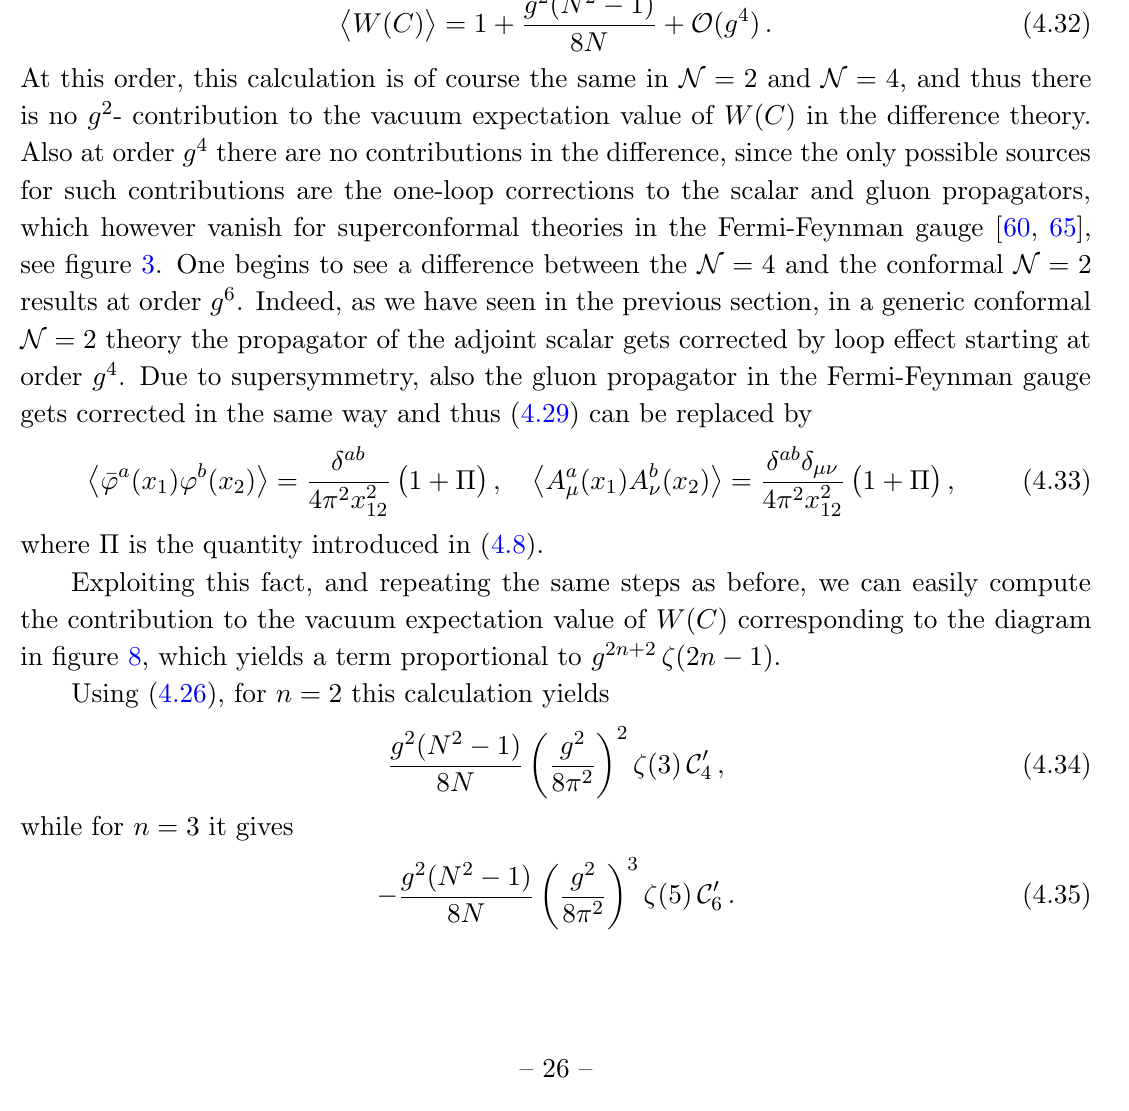
W ( C ) arising from the n -loop (cid:10) (cid:11)